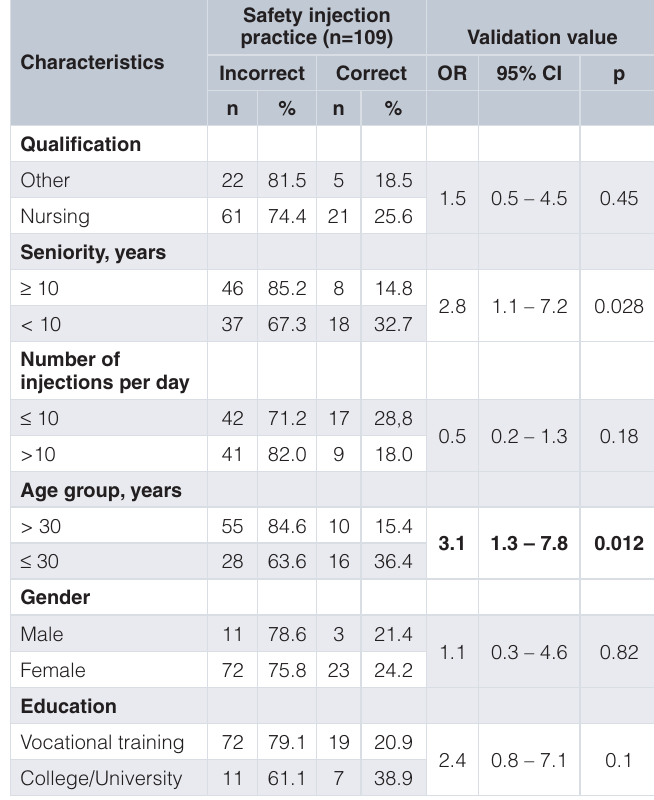
Table 5. Relationship between qualifications, seniority, number of injections per day and SI practice of